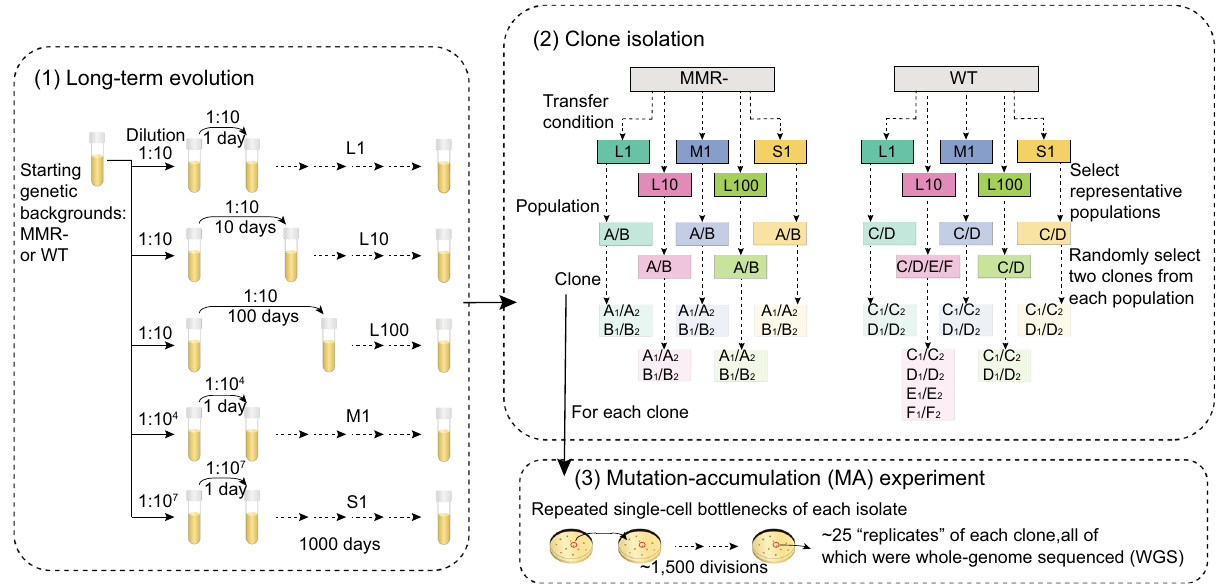
Fig. 1 | Mutation-rate evolution experiment. (1) Experimental evolution was run with two starting genetic backgrounds and fi ve transfer schemes with various dilution factors and transfer periods (L1, L10, L100, M1, and S1) for 1000 days. (2) After experimental evolution, 44 clones were isolated from evolved populations. Speci fi cally, we used two independent clones isolated from each of two